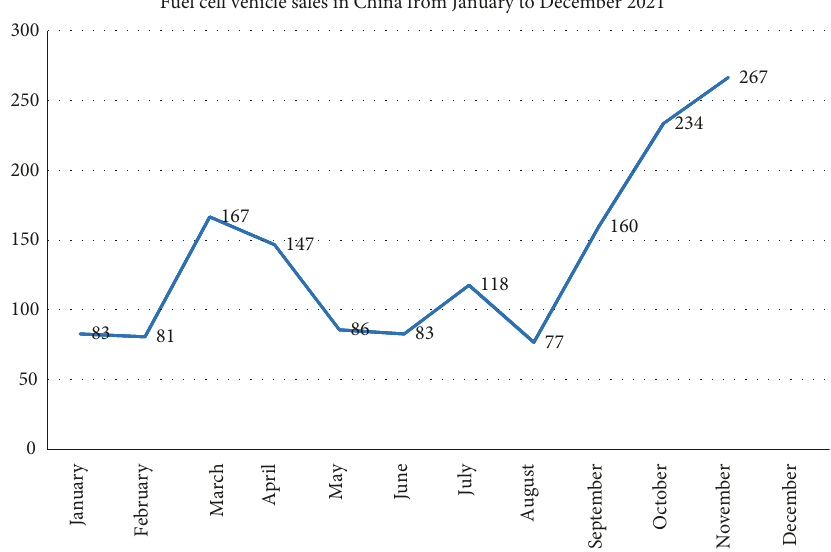
Figure 4: Fuel cell vehicle sales in China from January to December 2021.